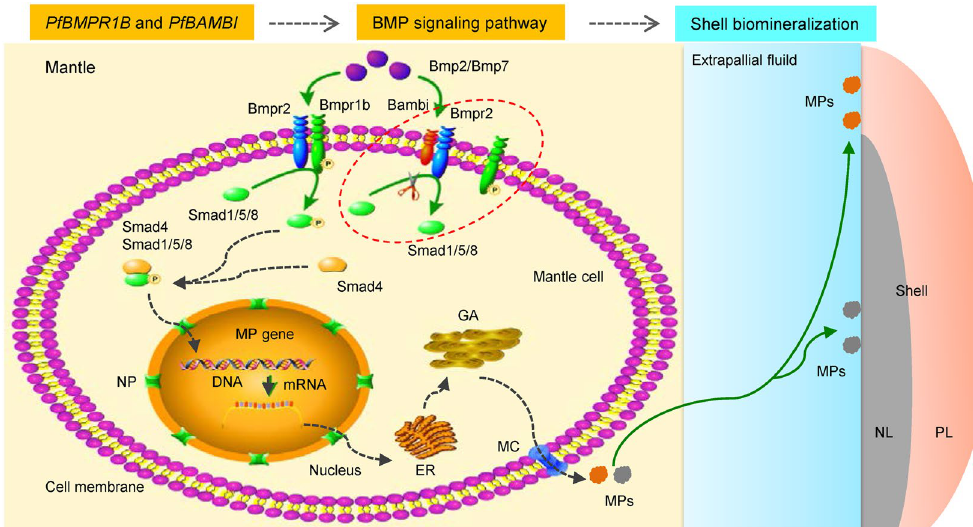
Figure 11. Schematic presentation of the mechanism for shell biomineralization mediated by the TGF β /BMP signaling pathway in molluscs. In the mantle, the ligand Bmp2 or Bmp7 binds to the complex of type I receptor Bmpr1b and type II receptor Bmpr2. Bmpr1b is phosphorylated by the constitutively active Bmpr2 kinase and thereby recruits a cytoplasmic Smad1/5/8 (R-Smad), which is then phosphorylated by activated Bmpr1b. Smad1/5/8 may dissociate from the receptors to form a heteromeric complex with Smad4 (Co-Smad). The Smad complex is transported into the nucleus, where it regulates the expression of specific matrix protein (MP) genes alone or by binding certain transcription factors (either corepressors or coactivators). The MPs may be synthesized through conventional ways throughout the endoplasmic reticulum (ER) and Golgi apparatus (GA) and secreted out of the mantle cells. Finally, the MPs arrive at the mineralization site on the surface of the shell, and the MPs with different functions regulate the formation of the nacreous layer (NL) and prismatic layer (PL). Bambi is a negative regulator and competitively binds to the ligands and Bmpr2, which cannot trigger the phosphorylation of Smad1/5/8, inhibiting the signal transduction in this pathway. The green arrows indicate known pathways, and the gray dotted arrows indicate potential pathways. The red dotted circle indicates the interactions of Bambi, Bmpr2 and Bmpr1b. NP: Nuclear pore. MC: Membrane